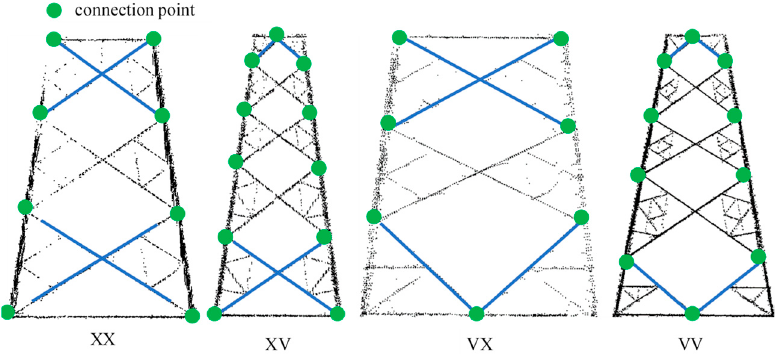
Figure 16. The type of the internal structure.